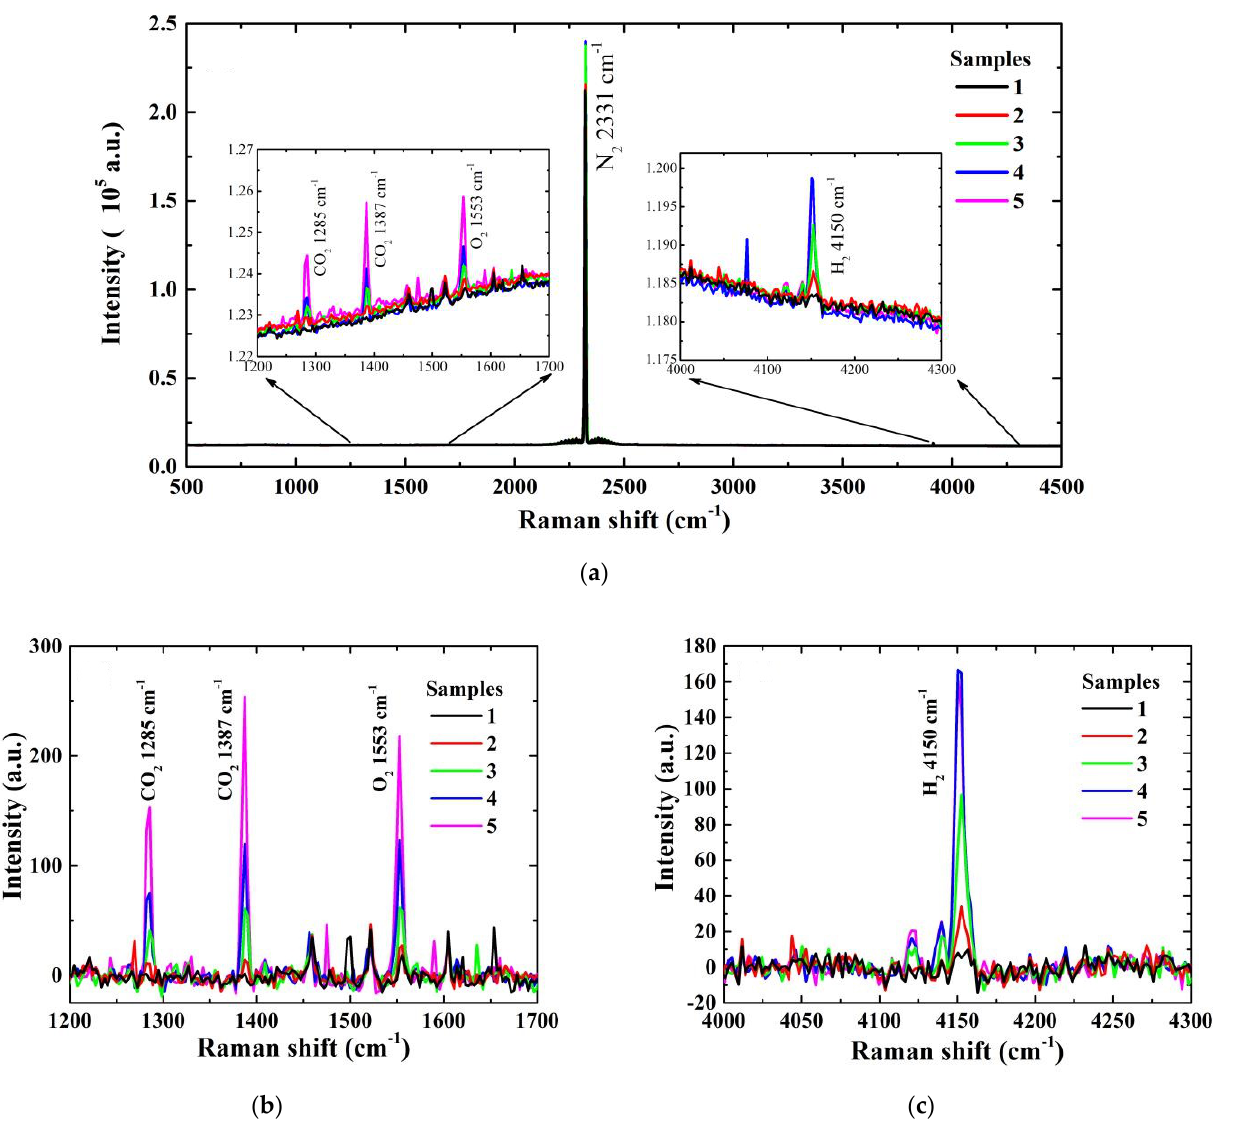
Figure 3. Raman original spectra of standard gas with 5 typical concentrations ( a ), and the spectra after baseline subtraction of CO 2 and O 2 ( b ) and H 2 ( c ).